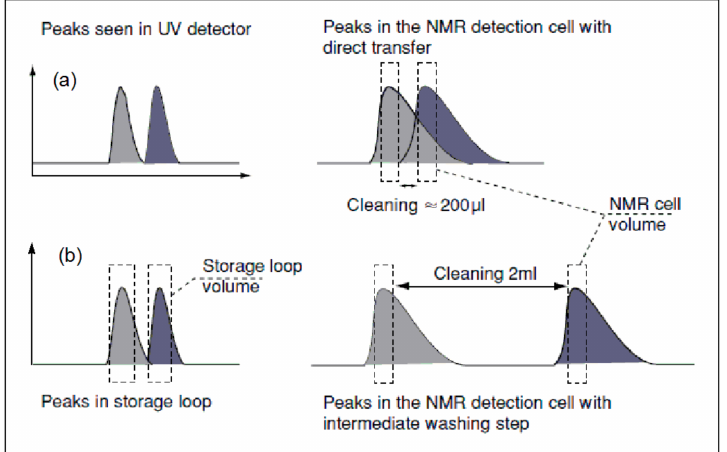
Figure 5. ( a ) Comparison of peak resolution of the direct stop-flow and ( b ) loop-storage/loop transfer procedures (reproduced from Ref. [16] with permission. Copyright © 2002, John Wiley & Sons, Ltd.).